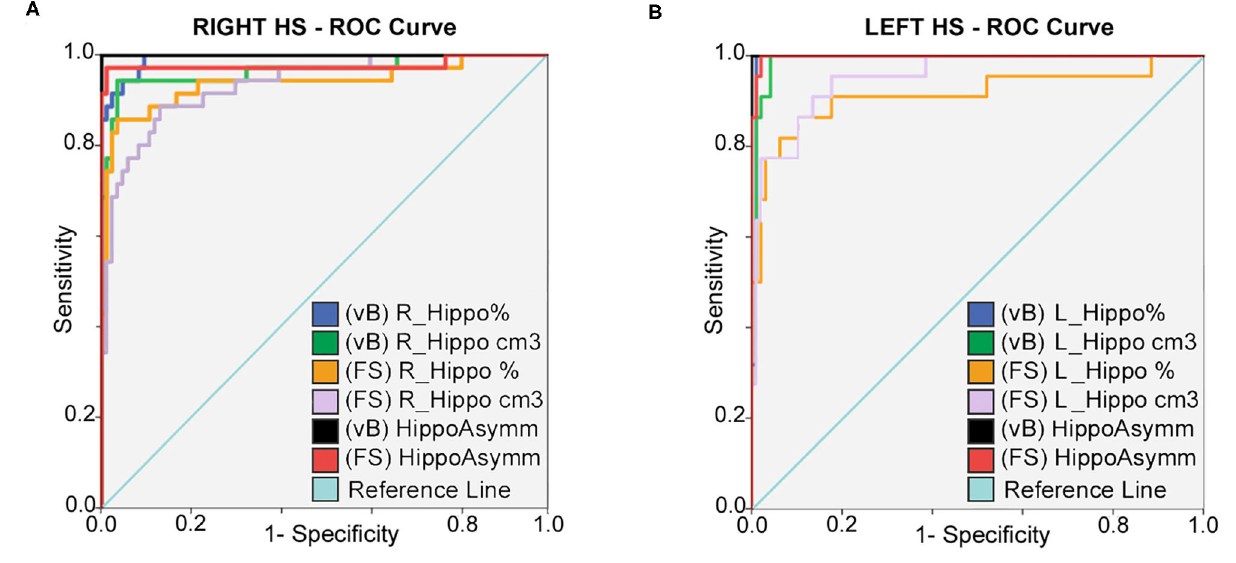
FIGURE 2 | ROC curves: sensitivity and specificity for classification between HC; right (A) and left (B) HS patients. Prediction is calculated for hippocampal volumes in percent of TIV; expressed in cm3 and also using asymmetry differences for both methods. Best accuracy was obtained using asymmetry values; hippocampal volume estimates from vB showed slightly better accuracy than